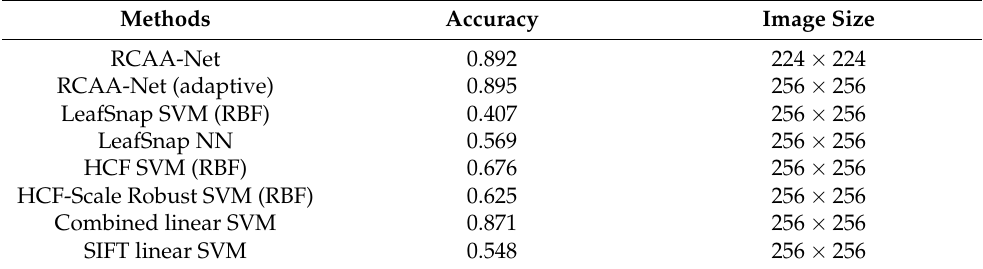
Table 2. The comparison results with the state-of-the-art methods.